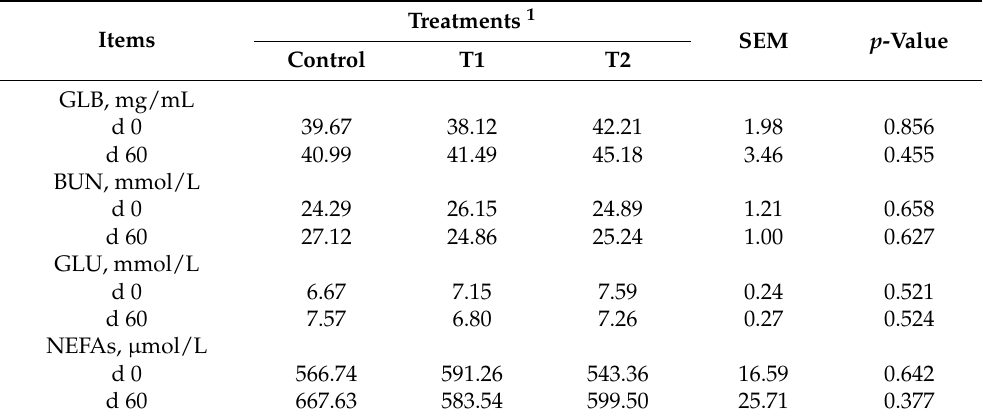
Table 4. Effect of Bacillus licheniformis and the combination of probiotics and enzymes on serum biochemical parameters of yak